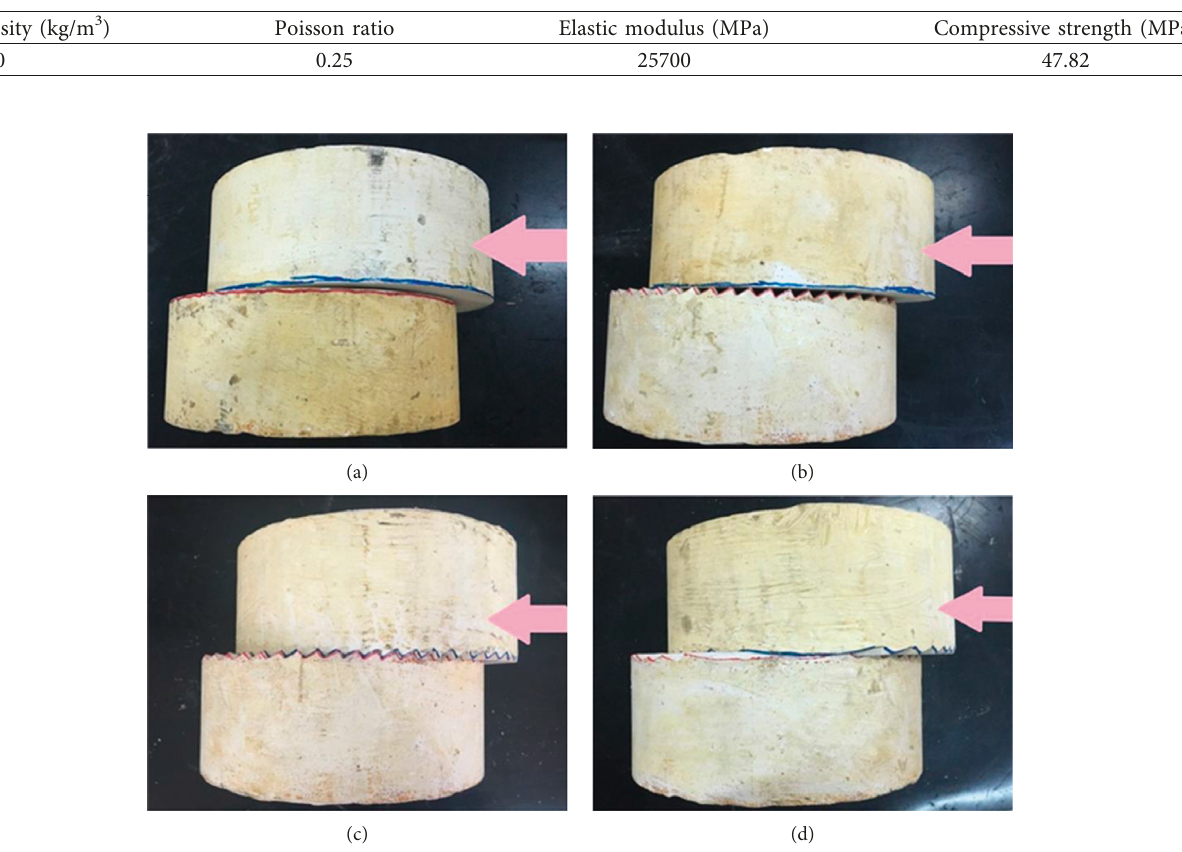
Figure 4: Structure of the test sample surface: (a) cross section of the smooth sample; (b) cross section of the rough sample; (c) surface of the smooth sample; (d) surface of the rough sample. Table 3: Sample